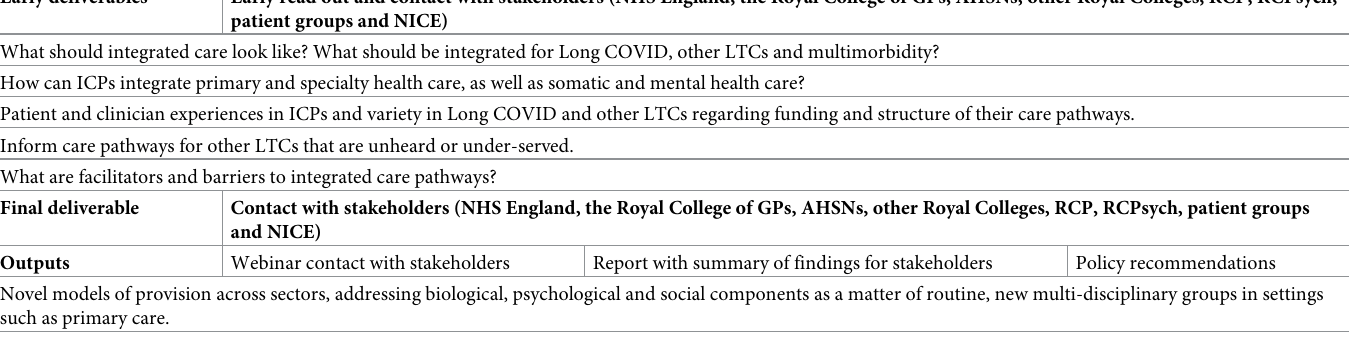
Table 2. Dissemination to